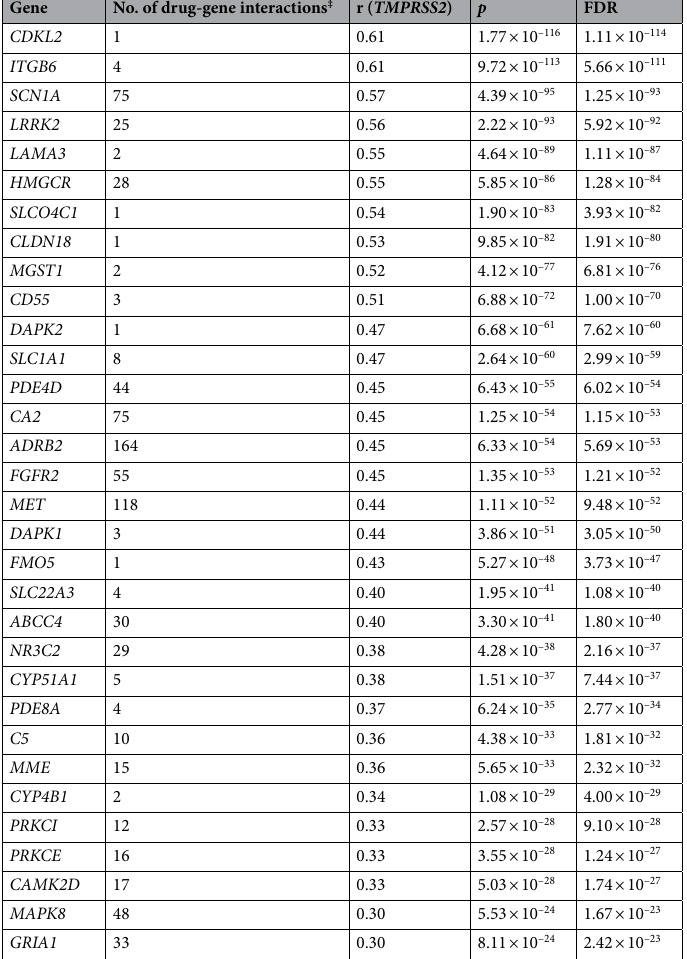
Table 3. Drug-gene interactions of TMPRSS2 -correlated genes. ‡ from Drug-Gene Interaction Database (DGIdb) 13 . r( TMPRSS2 ): Pearson correlation coefficient between gene and TMPRSS2 expression (adjusted for sex, age and centre). p: significance of the Pearson correlation coefficient (corresponds to Fisher’s Z score value), adjusted for false discovery rate